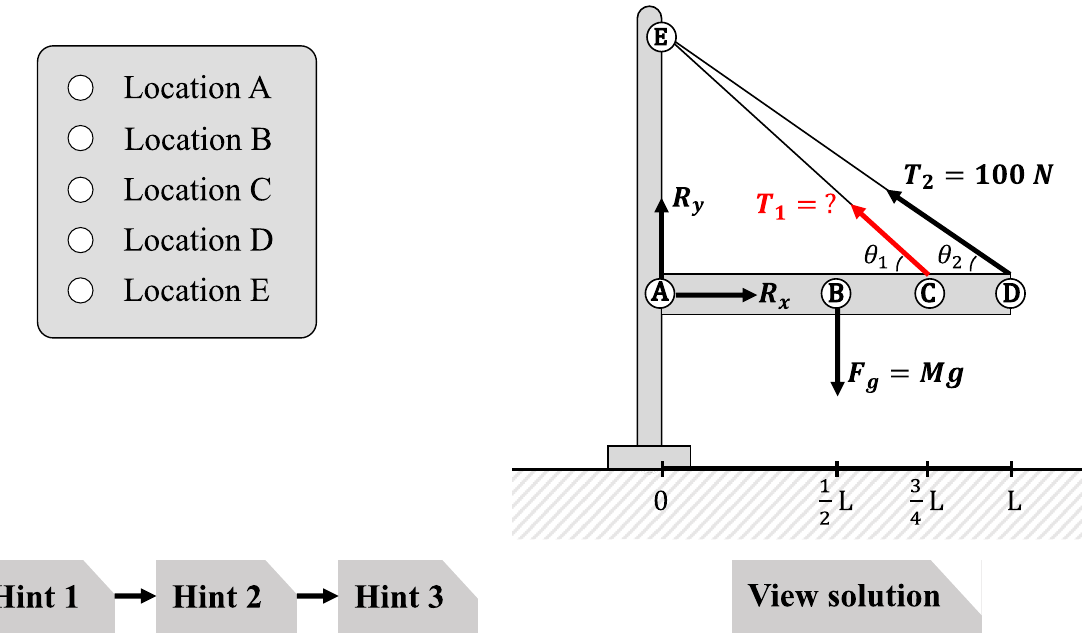
FIG. 6. Example of a subskill targeting the choice of pivot location